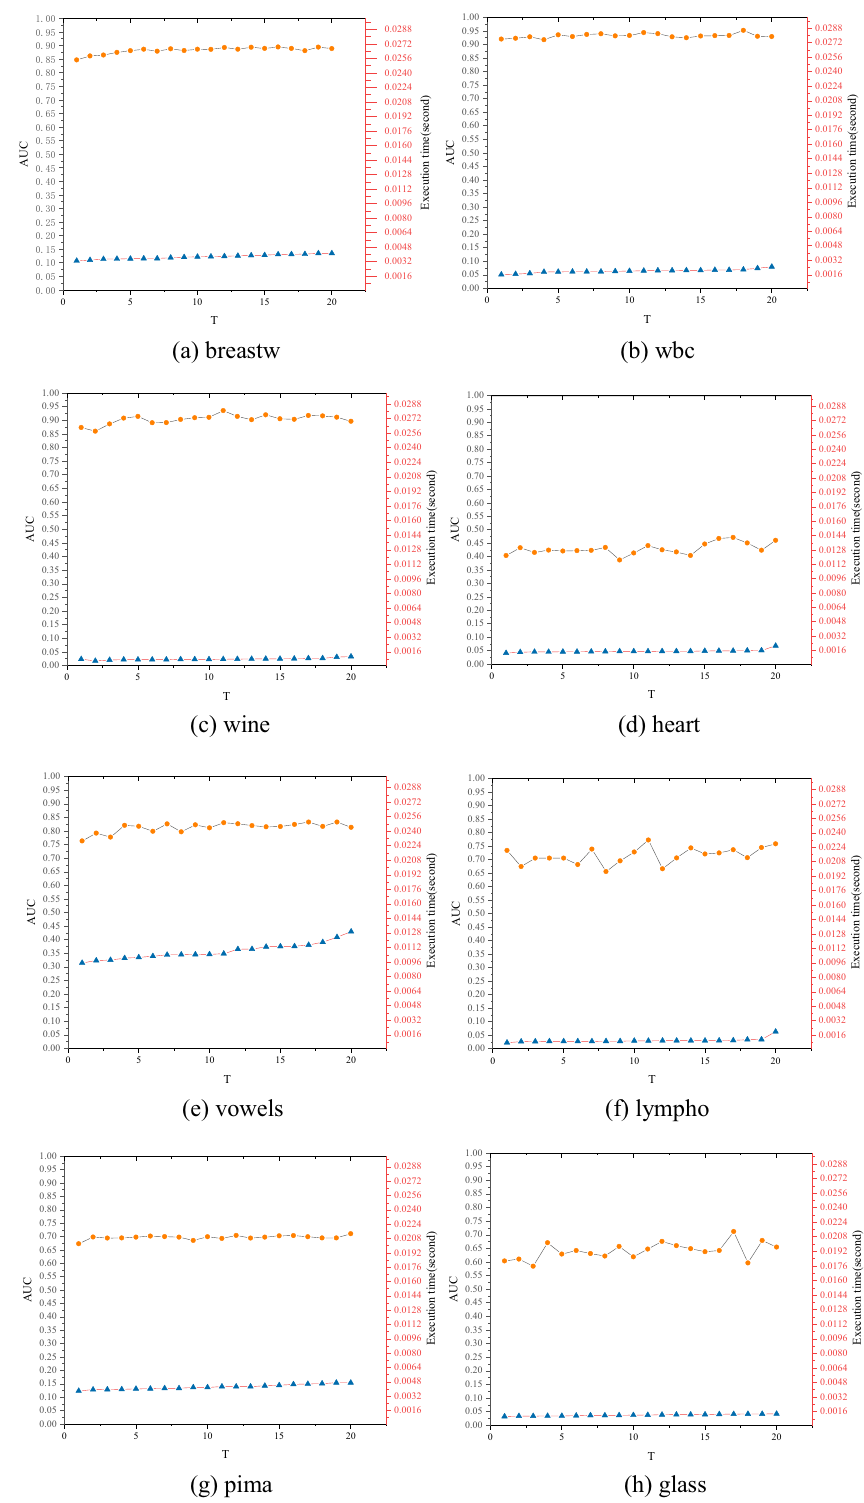
Figure 12. FBOD AUC performance (y1-axis) and execution time (y2-axis) versus the different graph numbers